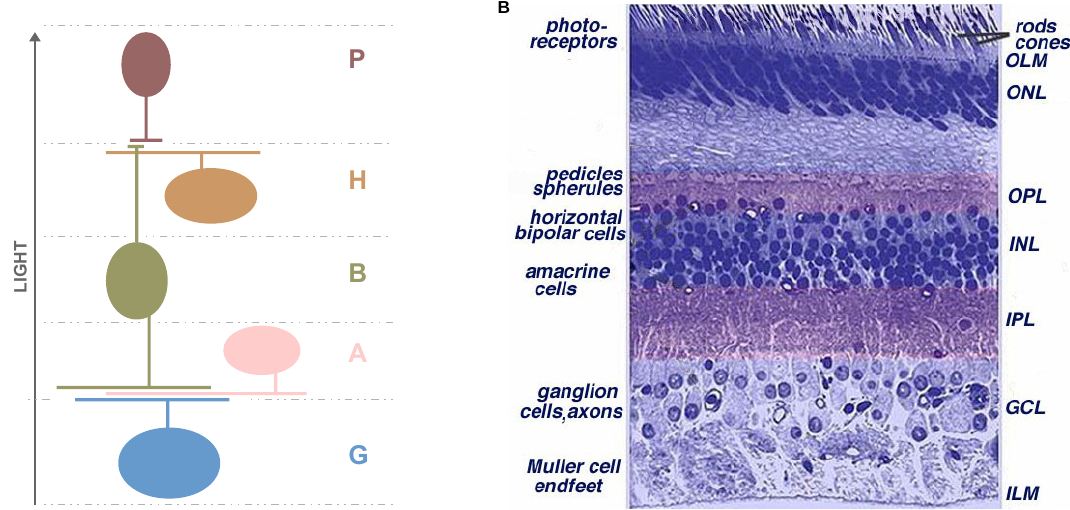
Figure 1. Anatomy of the retina. ( A ) Schematic diagram of the connections between the basic cell classes—photoreceptors (P), horizontal cells (H), bipolar cells (B), amacrine cells (A) and ganglion cells (G). Light rays must reach the sensory cells, the photoreceptors, passing through the entire retina. ( B ) Light micrograph of a vertical section of the central human retina (adapted from Webvision